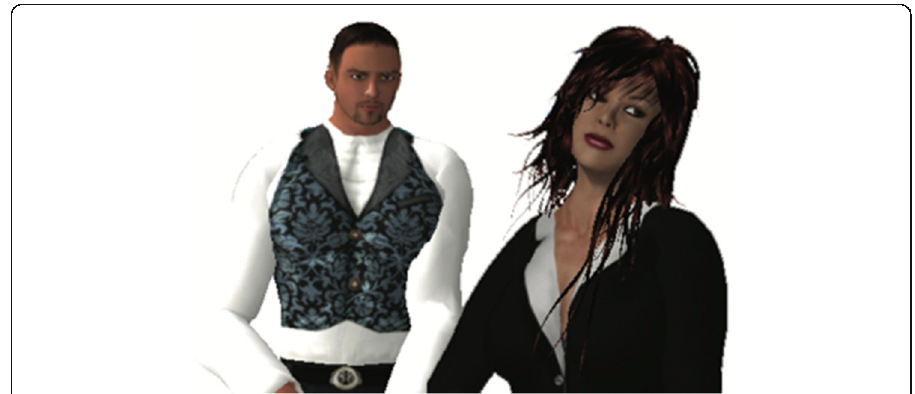
Fig. 1 Two avatars in Second Life (academics in “ real life ”